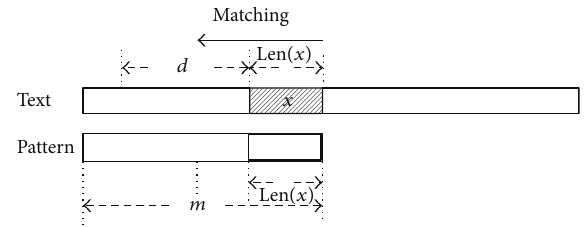
Figure 1: Matching the substring of text from pattern.